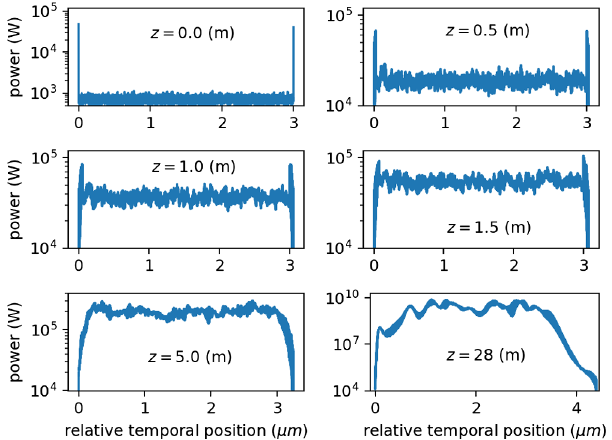
10. Temporal radiation profile with CSE from the wiggler entrance to saturation. In order to reduce the computational loads, we increased current to 2 kA and reduced bunch length to 3 μ m. (We have used 0.5 kA and 120 μ m in Fig.